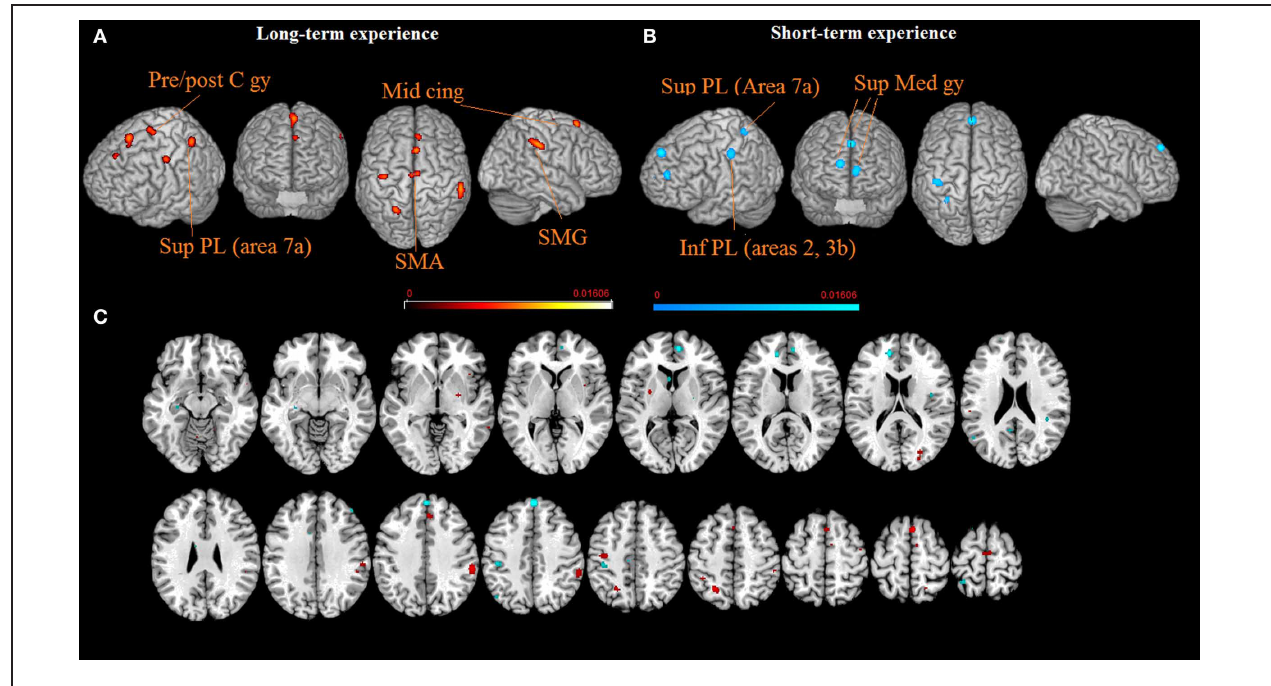
FIGURE 2 | The brain networks supporting long-term (A) and short-term (B) meditation experience are displayed on a rendered template brain provided by spm5 and on axial slices of the MNI single subject template, with long-term (orange) and short-term